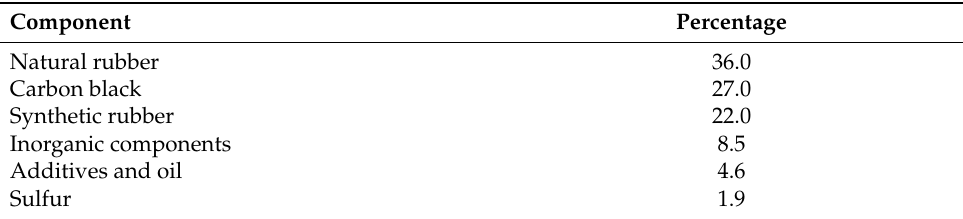
Table 1. Parameter values from the TGA and DTG curves for GTR.